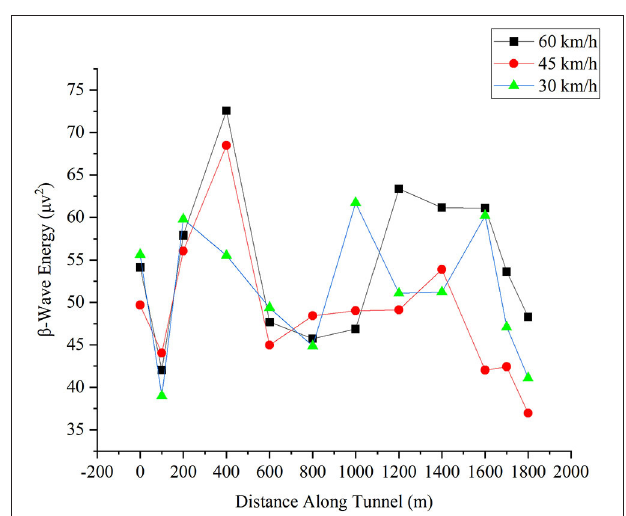
FIGURE 7 | Change in β -wave energy in the frontal lobe for different driving